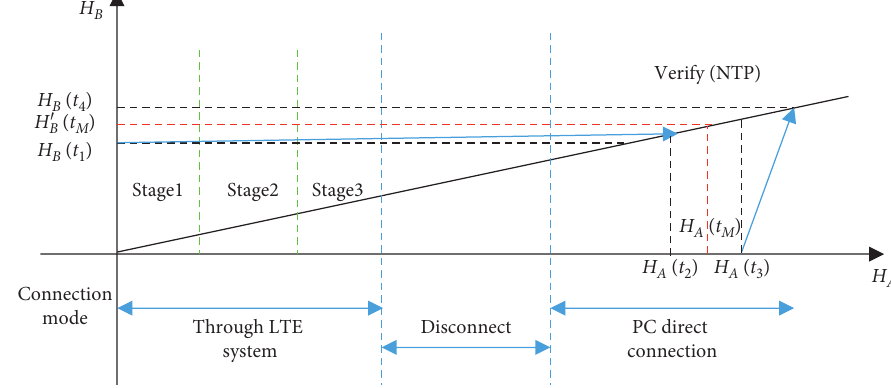
Figure 5: Feasibility verification of asynchronous measurement. Table 1: Parameters of delay error in the verification stage.